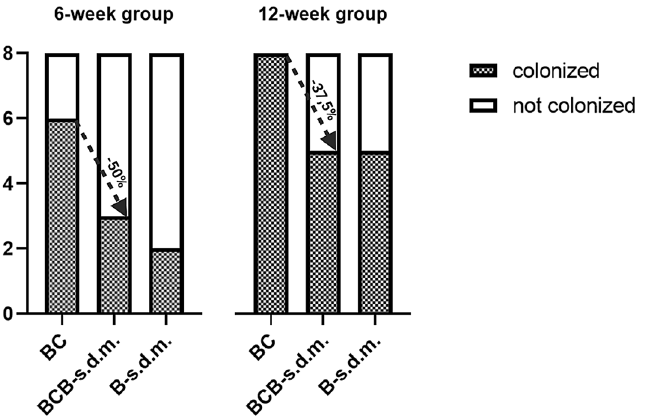
Figure 4. Microbiologic results after sonication and subsequent plating. Observed implant colonization rate (bacterial growth) in the 6- and 12-week-group. In both groups, bacterial colonization rate of BC was higher than for the underlying BCB-s.d.m. No corresponding BCB-s.d.m. colonization was observed in 50% and 37,5% of the cases in the 6- and 12-week group, respectively. The control group (B-s.d.m.) is reported as